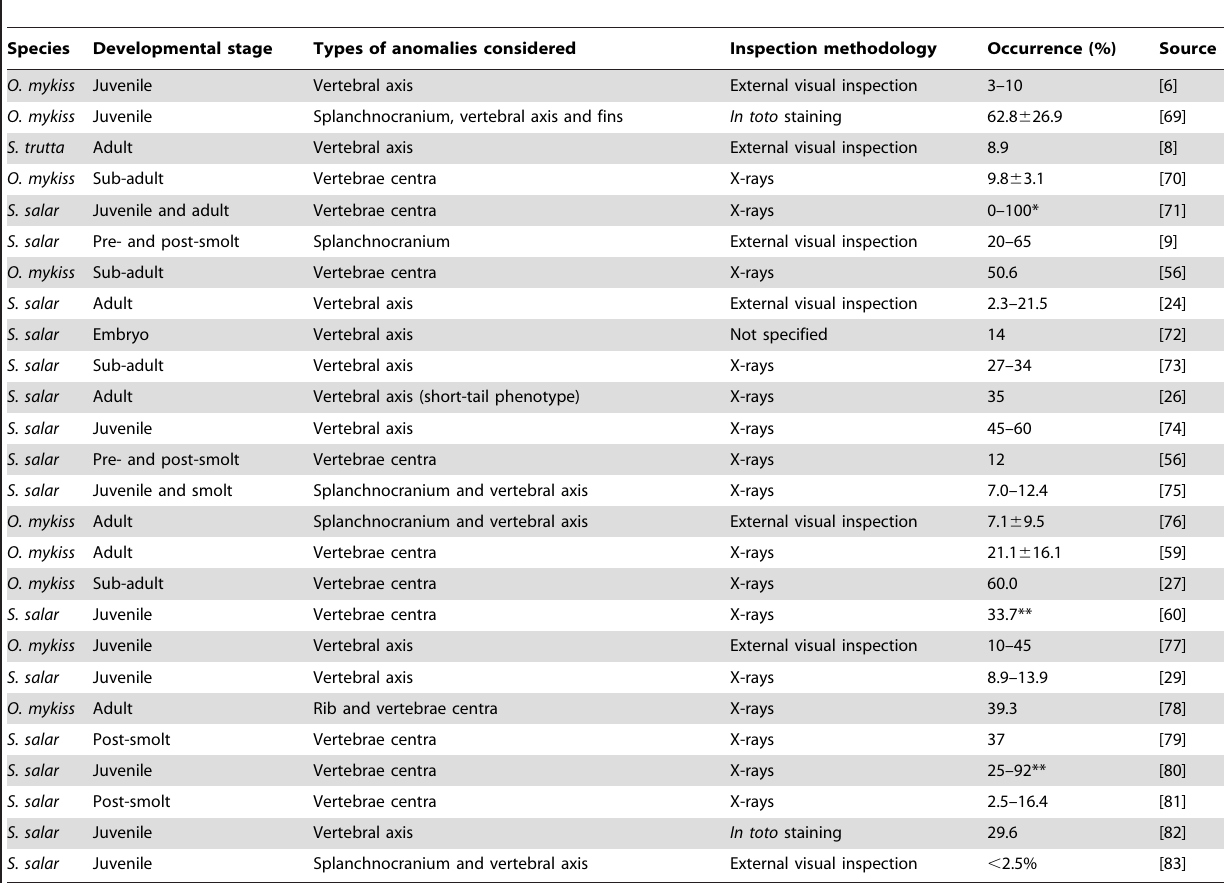
Table 10. Summary of some previous studies on salmonid skeletal anomalies. Occurrence refers to the percentage of affected individuals (mean 6 S.D., range or